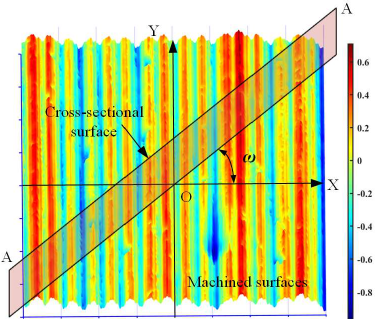
Figure 7. Schematic of the cross-sectional surface contours (A-A) used for calculating the 2D fractal